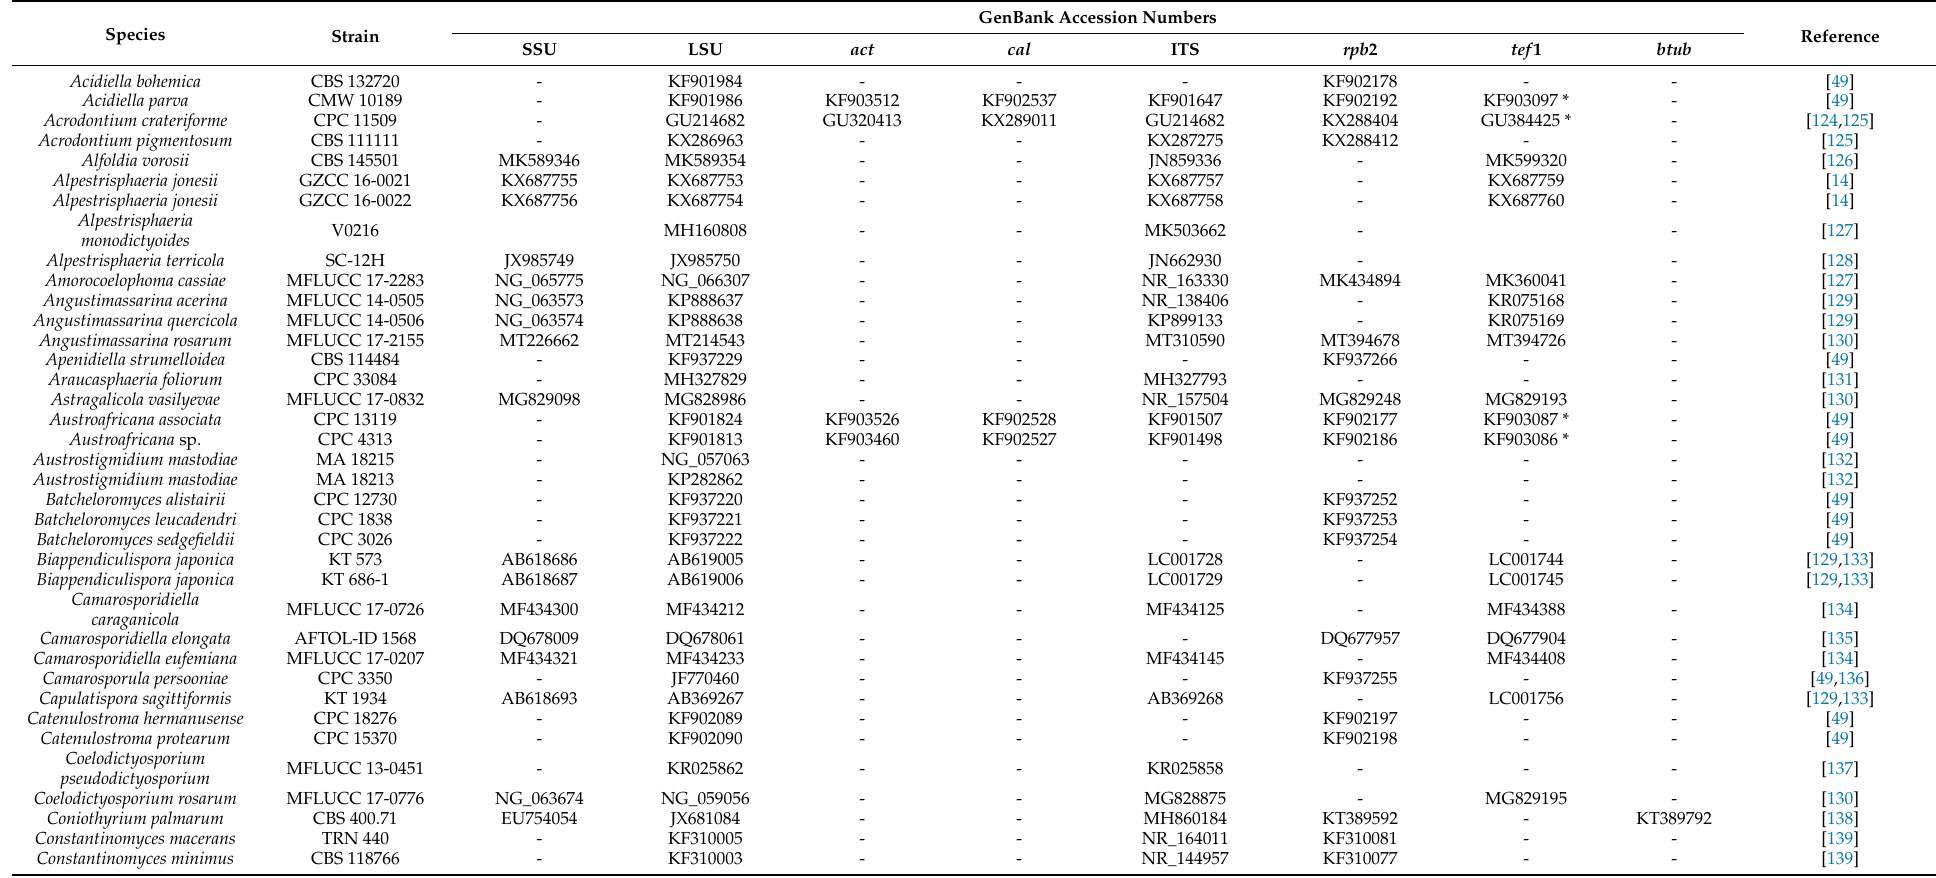
Table 3. Taxa used in the phylogenetic analyses and their corresponding GenBank